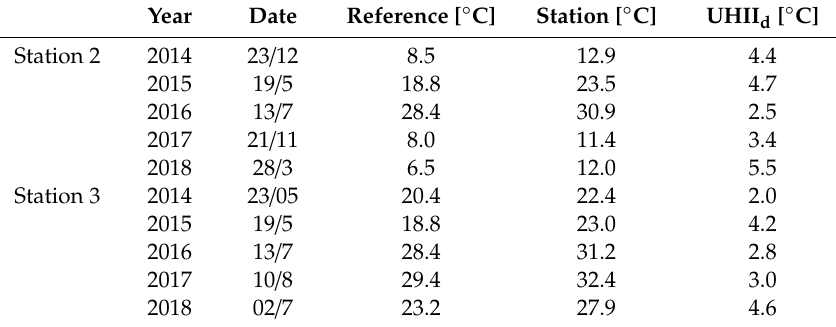
Table 4. Maximum average daily temperatures (UHII d ) for stations 2 and